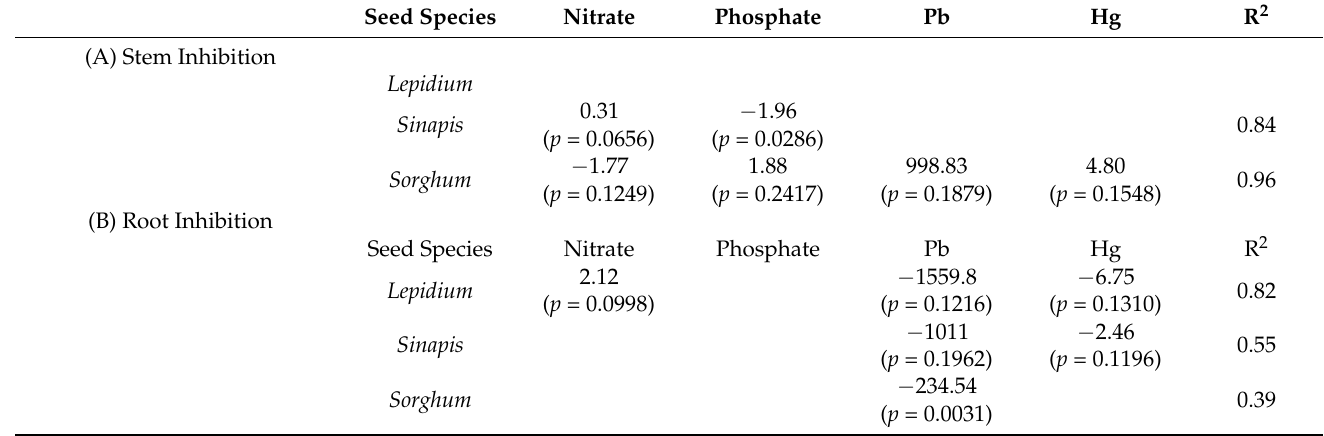
Table 2. Stepwise regression with the estimates of the relationship between nutrient (nitrate and phosphate concentration in mg/L) and metal (Hg, Pb) concentration in ppm with stem and root growth inhibition of Lepidium sativum , Sinapis alba and Sorghum sachharatum in wetland sites 1–6, along with appropriate R 2 and p values. The blank spaces revealed no estimates of